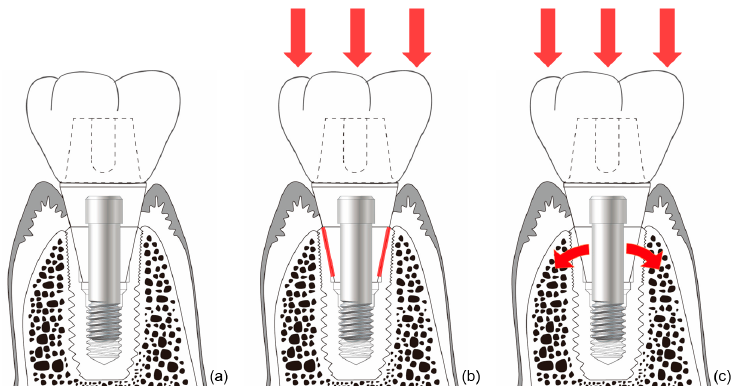
Figure 6. Schematic drawing of bone stimulation. When occlusal force is applied to an internal connection-type implant, the implant around the connection expands and stimulates the surrounding bone to induce bone proliferation. ( a ) Internal friction connection-type implant. ( b ) The occlusal force is transmitted to the implant through the conical connection parts (red lines). ( c ) The coronal expansion of the implant (curved red arrows) becomes the source of the strain that stimulates the alveolar bone.